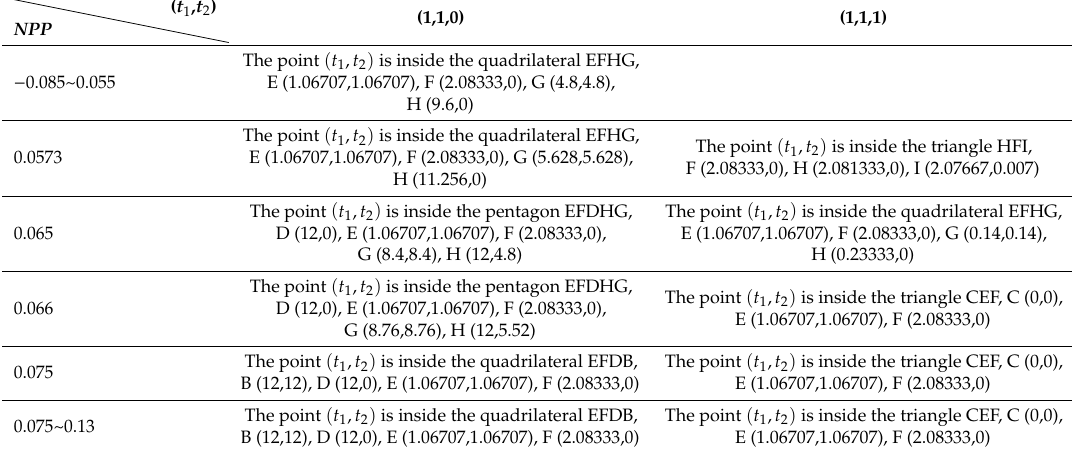
Table A3. Influence of NPP on energy storage charging and discharging time decisions in power